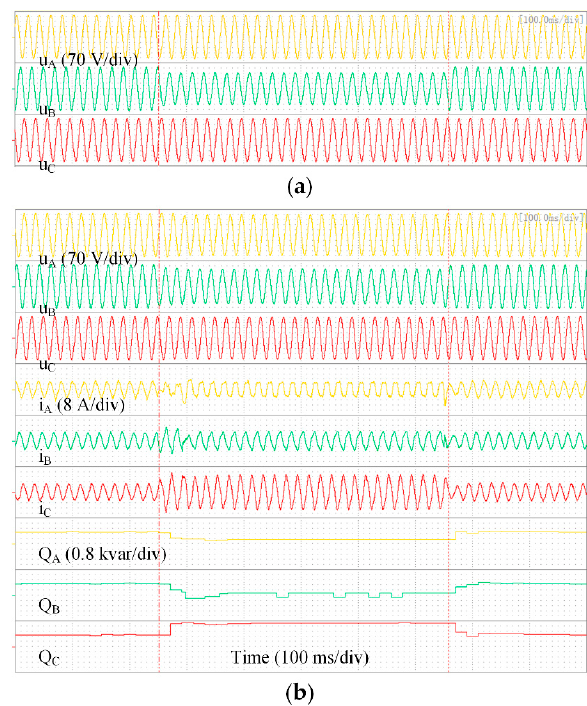
Figure 8. Three-phase voltages, currents, and reactive power measured at breaker B1 under single phase-to-ground fault. ( a ) Without SVG compensation (the currents and reactive power are zero); ( b ) With SVG compensation.